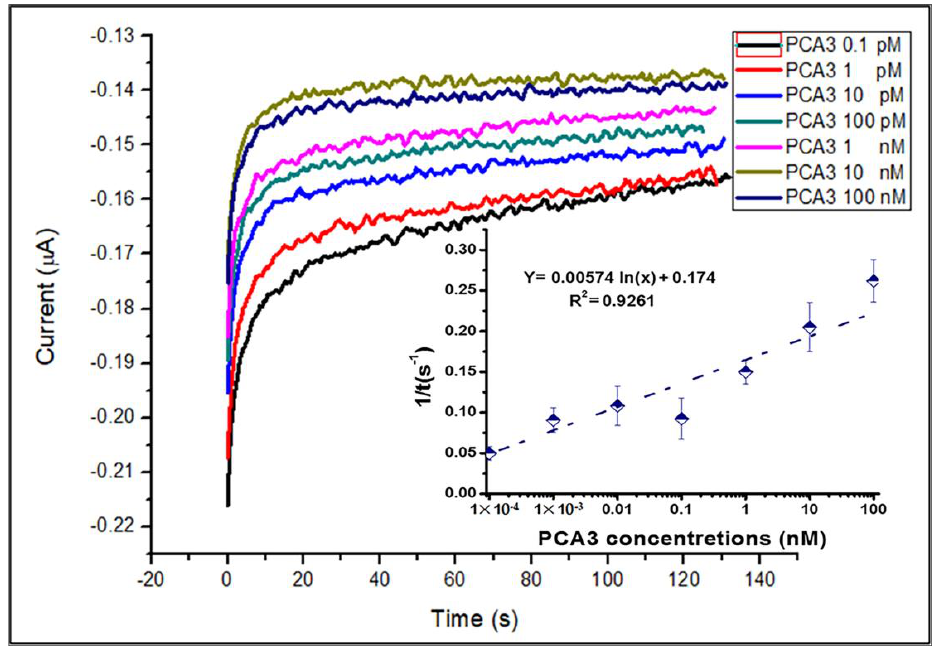
Figure 6. The time dependencies of current at −0.25 V were recorded at different concentrations of PCA3 in buffer solution. Inset shows the dependence of reciprocal time constant (1/τ) against the concentration of PCA3.